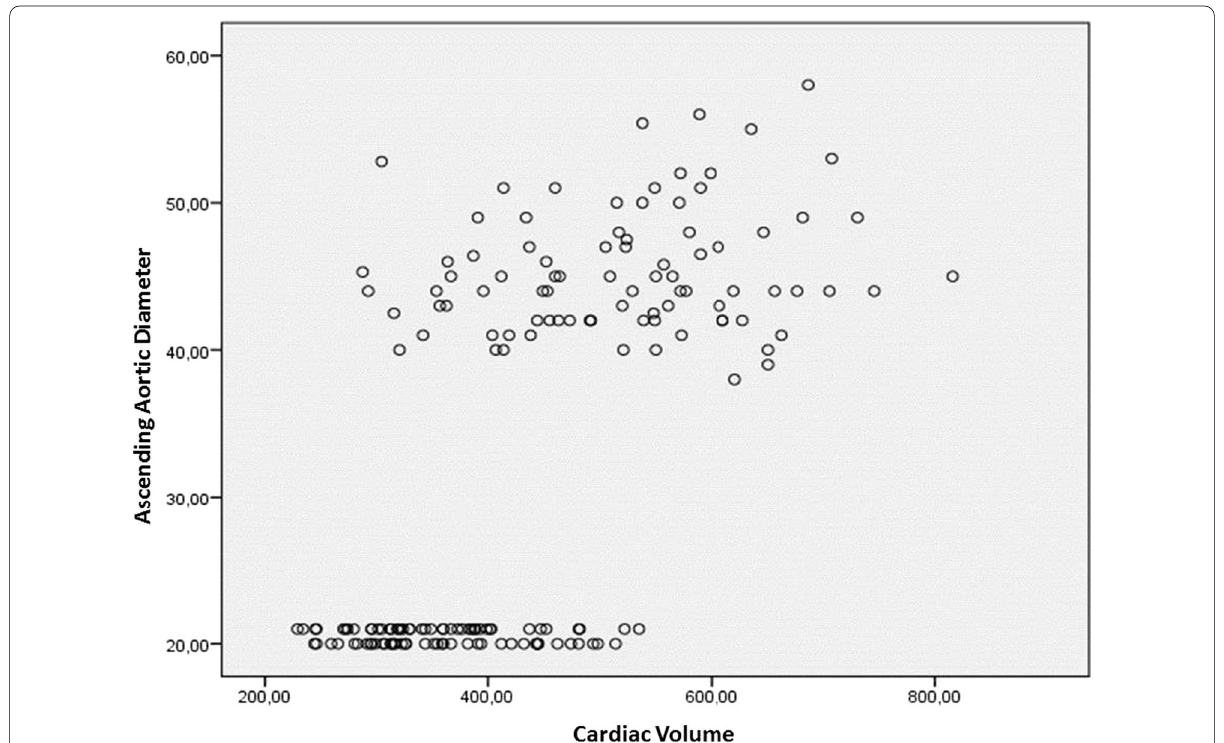
Fig. 2 The correlation between Aortic diameter and Cardiac